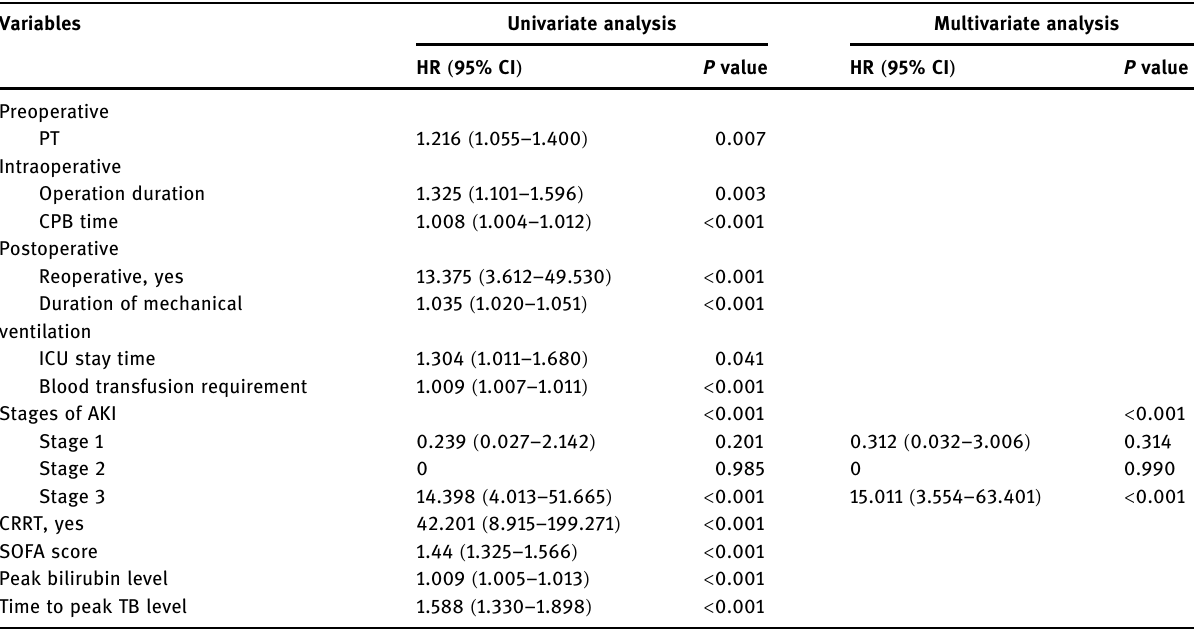
Table 5: Cox regression analyses of the risk factors of long - term survival Variables Univariate analysis Multivariate